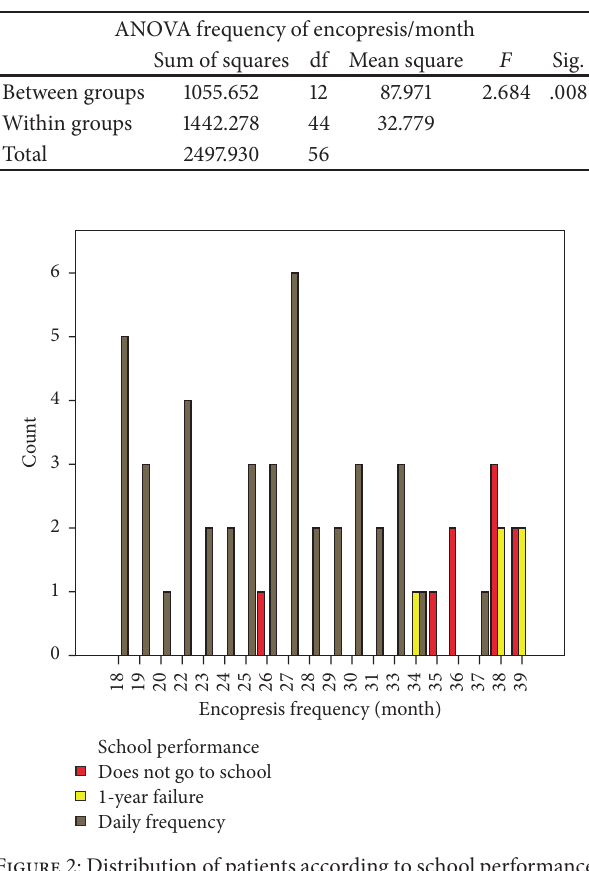
Figure 2: Distribution of patients according to school performance and number of encopretic episodes per month.